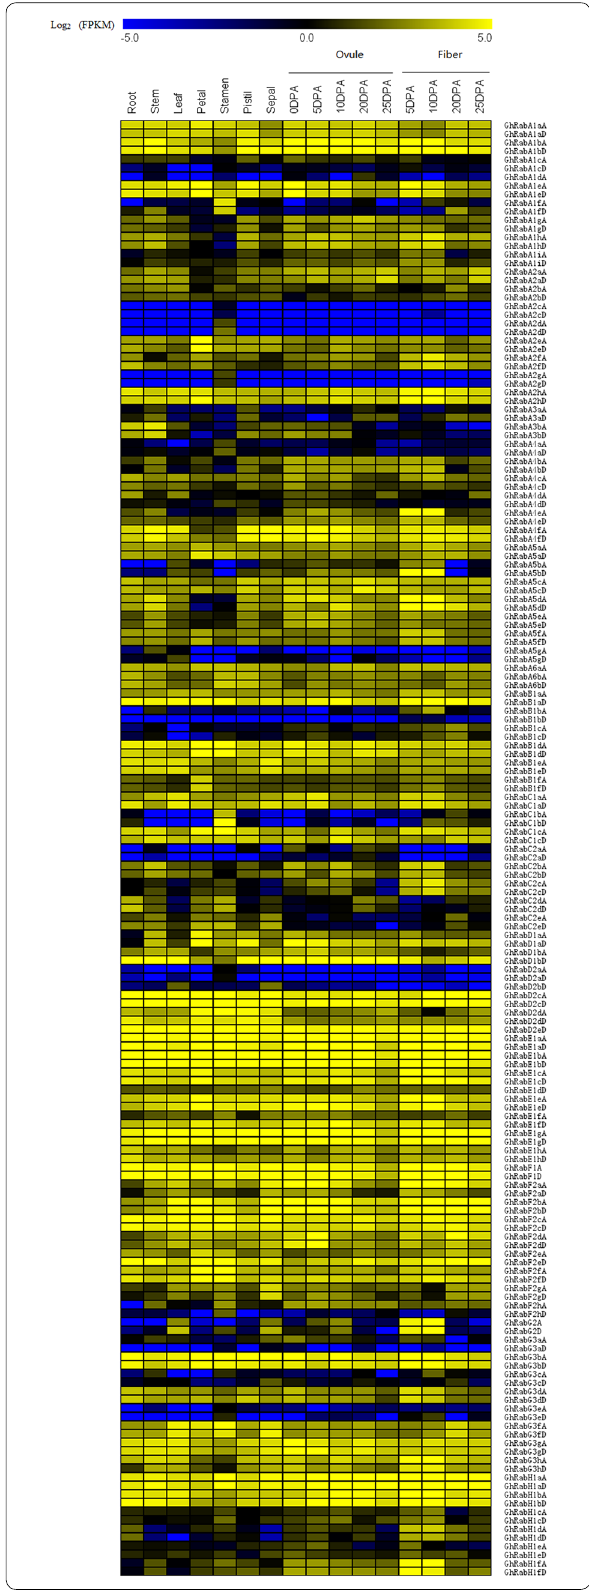
Fig. 4 Expression profiles of Rab genes in cotton. The RNA-seq rela- tive expression data of 16 tissues was used to re-construct expression patterns of 169 Rab genes in G. hirsutum acc. TM-1. Analysis method of data model expression as follows: if the value of log 2 FPKM is more than 1, we consider it to be expressed and if the value of log 2 FPKM is less than or equal to 1, we consider it not to be expressed